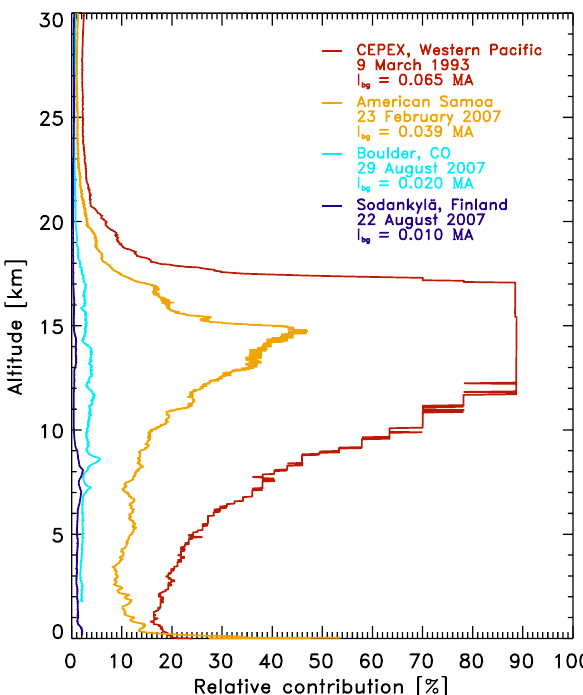
Fig. 1. Ratio of background current measured before launch to total cell current measured during flight for two tropical profiles, one typical mid latitude and one typical high latitude